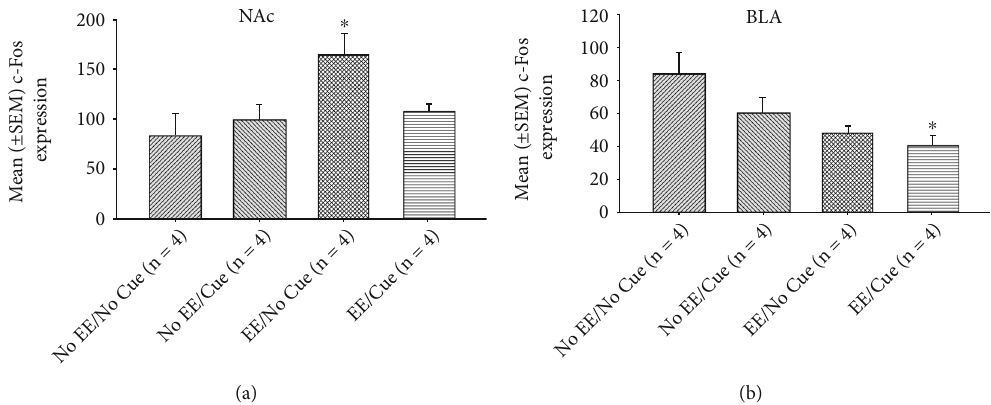
Figure 9: Mean ( ± SEM) c-Fos expression in the NAc (a) and BLA (b) for the no EE/no cue ( n = 6 ), no EE/cue ( n = 6 ), EE/no cue ( n = 6 ), and EE/cue groups ( n = 6 ). EE: environmental enrichment. ∗ p < 0 : 05 indicates signi fi cant di ff erences compared to the no EE/no cue group; # p < 0 : 05 indicates signi fi cant di ff erences compared to the no EE/cue group.